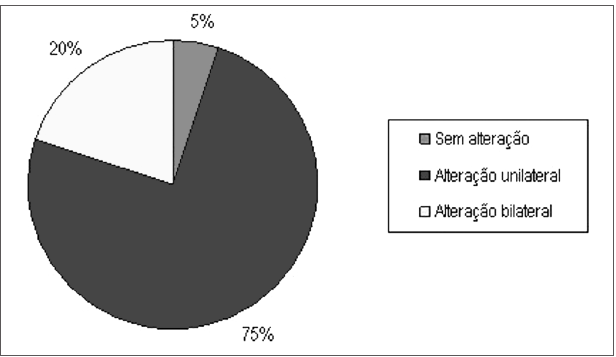
Figura 3. Porcentagem de alterações no IPRF, ocorridas após a expo- sição à música na relação S/R - 5 dB.